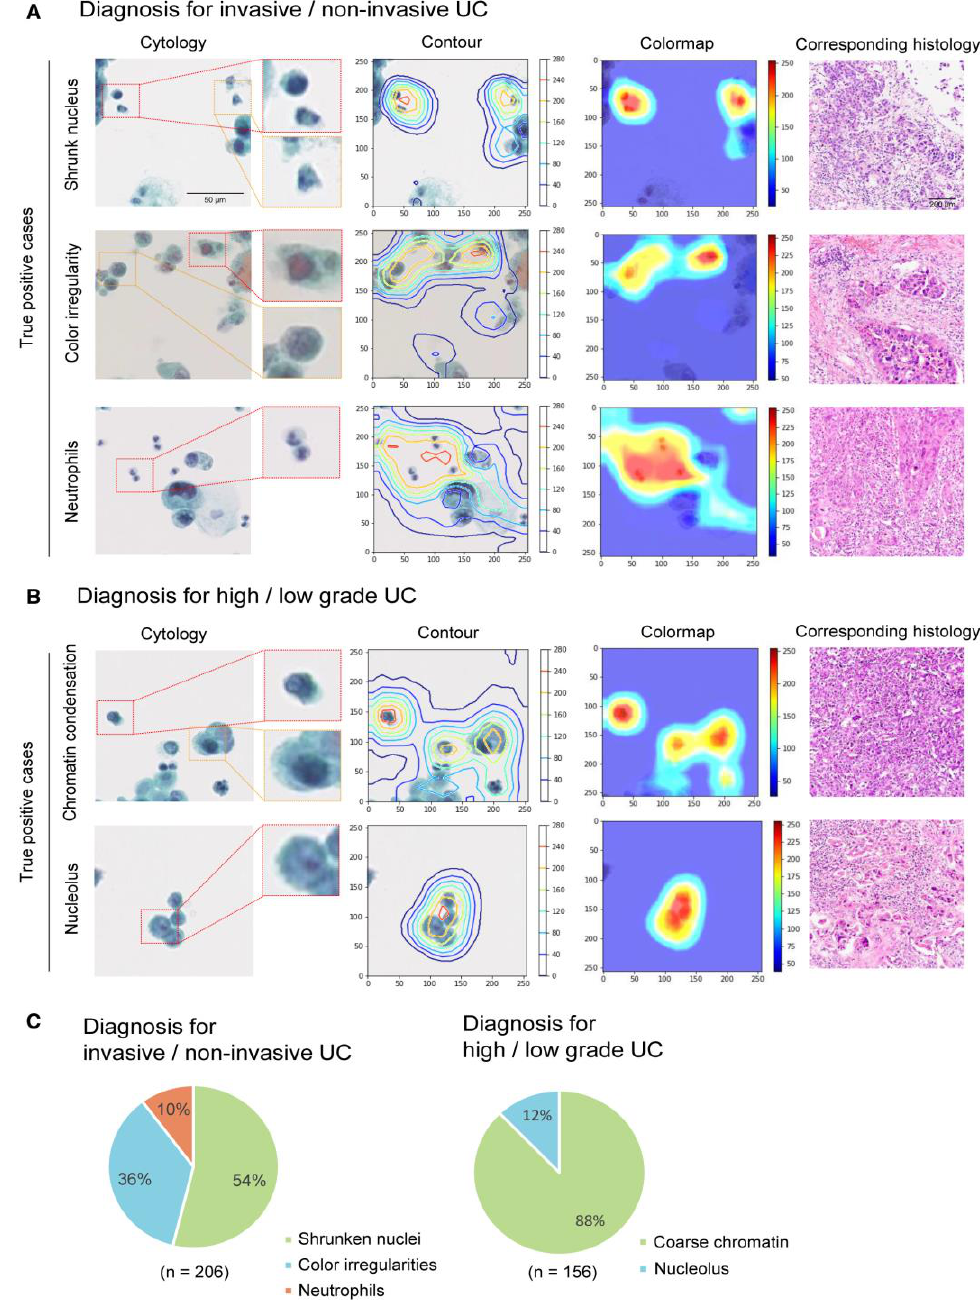
Figure 9. Example of stromal and nuclear grading using cytological images. Gradient-weighted class activation mapping (Grad-CAM) is illustrated. ( A ) Representative cytology images were observed using Grad-CAM and corresponding hematoxylin and eosin (H&E) histology images of invasive or noninvasive urothelial carcinoma (UC). Cytology images with a true-positive diagnosis contained cells with shrunken nuclei, nuclei with color irregularities, or neutrophil infiltration. ( B ) Representative cytology images were observed using Grad-CAM and corresponding H&E histology images of high-grade or low-grade UC. Cytology images with a true-positive diagnosis contained nuclei with coarse chromatin or an obvious nucleolus. ( C ) Pie charts indicate the proportions of findings associated with a true-positive diagnosis of stromal invasion or nuclear grading in the corresponding histology image. (Source: Figure 4 in Nojima et al. Reprinted with permission from the authors. Copyright (2021), Cancer Cytopathology, ACS journal [47] .)